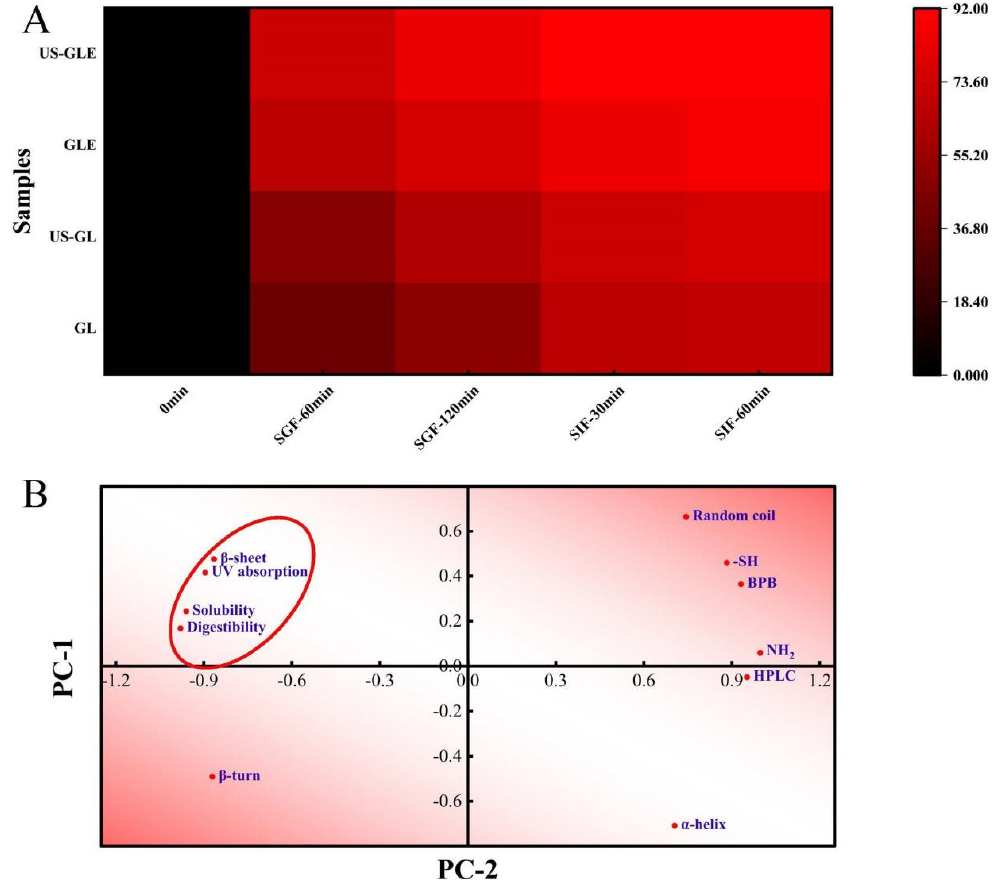
Figure 5. Heat map of digestibility with time ( A ). Principal component analysis ( B ) was performed on the secondary structure ( α -helix, β -fold, β -turn, and random coil), UV-vis wavelength scan (UV absorption), group content (-SH and -NH 2 ), exposure of hydrophobic group (BPB), HPLC elution time (HPLC) and final digestibility (digestibility) of the previously described samples, with PC-1 accounting for 79.87% of the data and PC-2 accounting for 18.35% of the data. The red ellipse indicates the clustering of physicochemical, structural characteristics with digestibility.